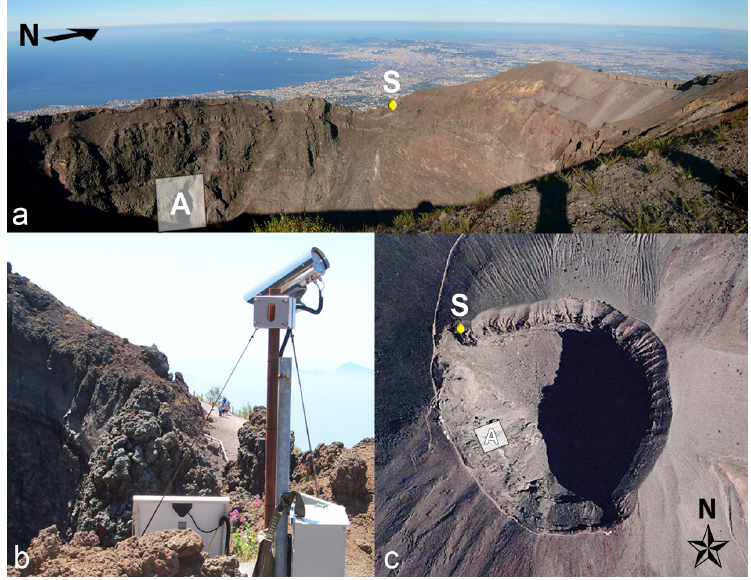
Figure 1. a) View from eastern rim of Vesuvius crater: b) ICARO station installation; c) top view of Vesuvius crater. S = ICARO station lo- cation, A = area acquired by IR